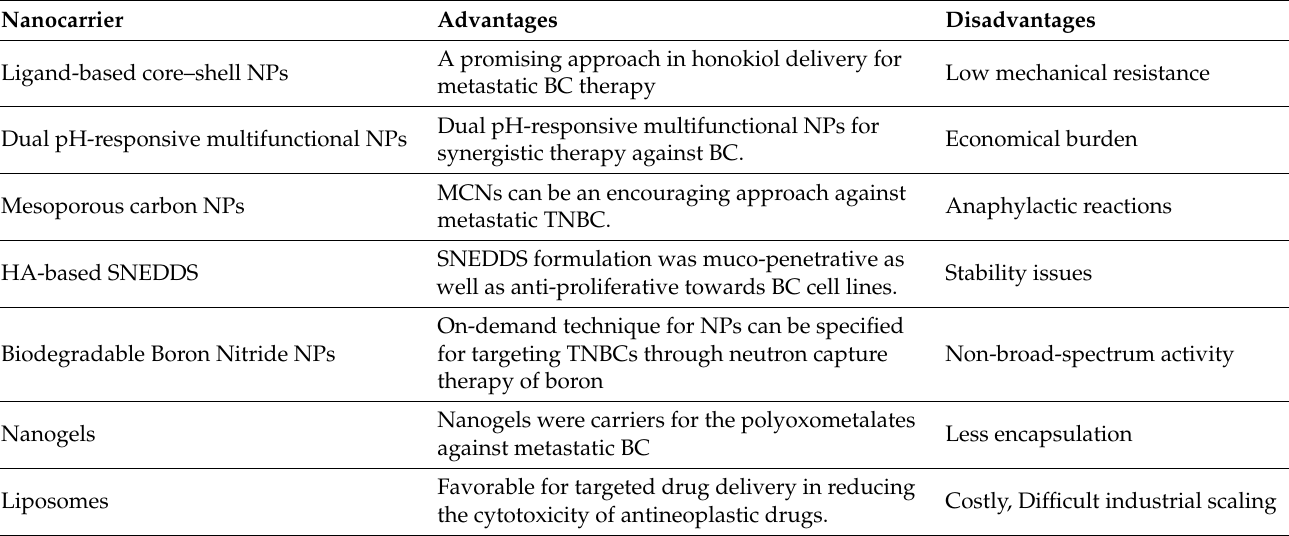
Table 3. Advantages and disadvantages of different strategies against